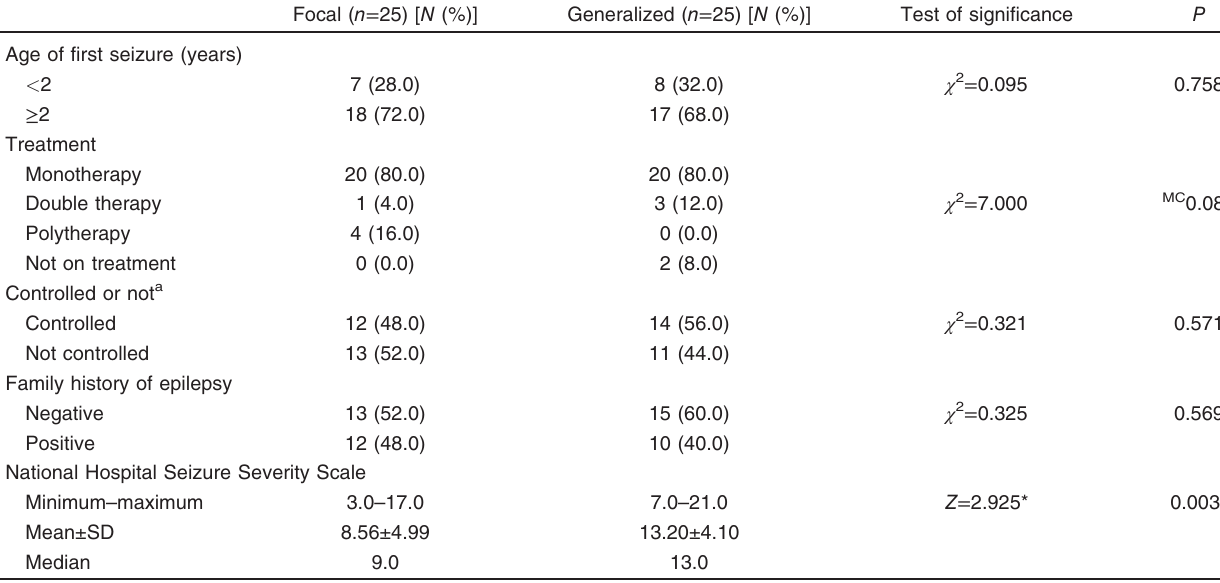
Table 2 Comparison between the studied groups (focal and generalized epilepsy) according to epilepsy